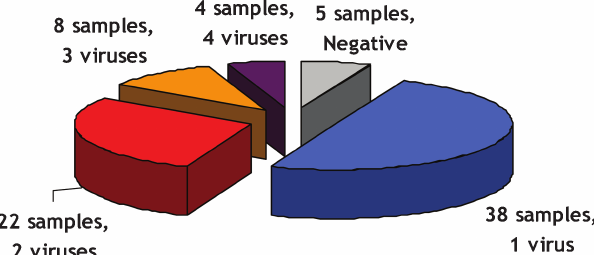
Figure 1 - Sample distribution of the number of viral agents identified by nasopharyngeal aspirate in 77 infants with bronchiolitis.